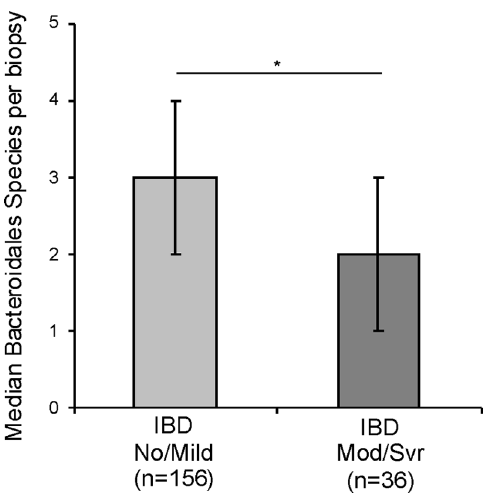
Figure 3. Bacteroidales species diversity by degree of inflam- mation. The median number of species per IBD biopsy detected from biopsies with no or mild inflammation (No/Mild) compared to IBD biopsies with moderate to severe inflammation (Mod/Svr). Error bars represent inter-quartile ranges. N equals the number of biopsies in each group. * P =0.02.